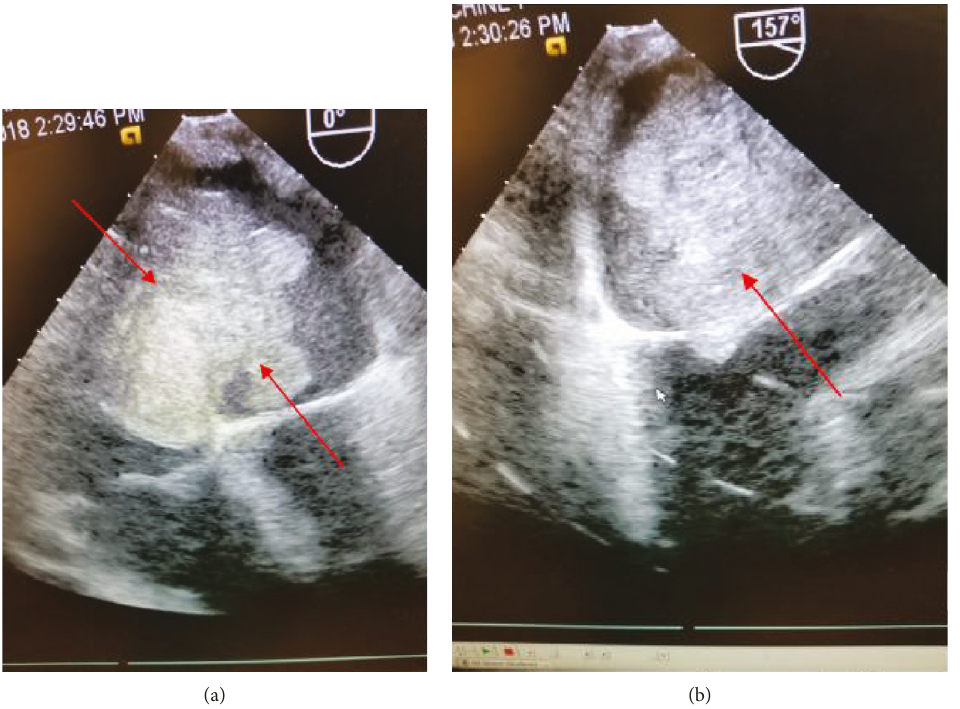
Figure 3: Transesophageal echocardiogram (intraoperative) demonstrating the mass in the left atrium invading the interatrial septum.